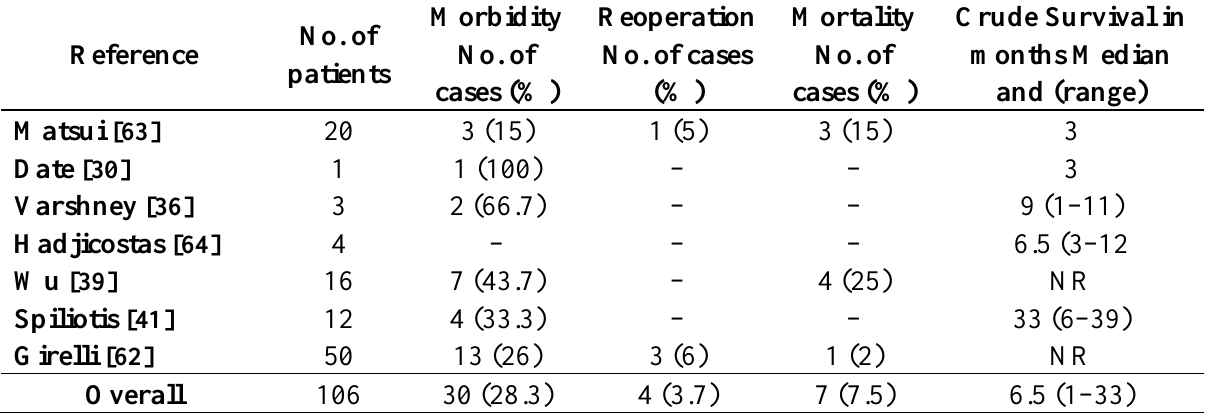
Table 3. Frequency of postoperative and long-term results for 106 patients who received radiofrequency ablation for pancreatic adenocarcinoma. Data are reported as absolute number, frequency, median and range. NR: Not reported.